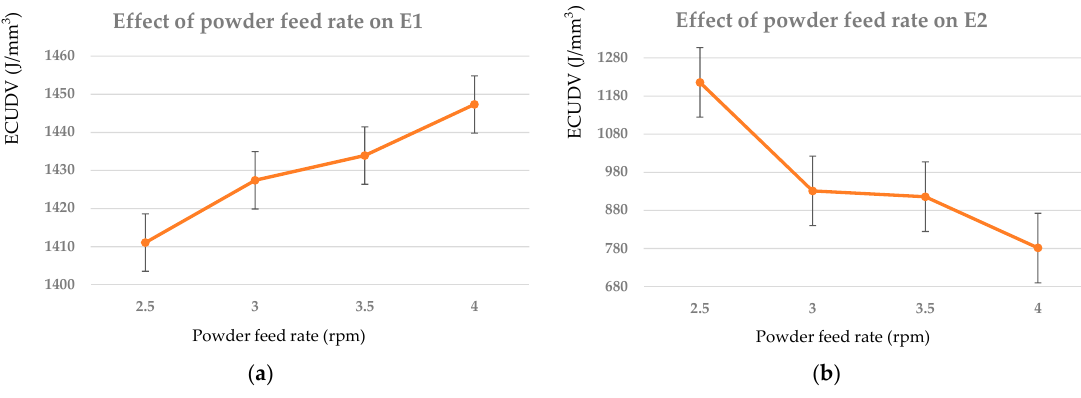
Figure 6. Effect of powder feed rate: ( a ) theoretical value and ( b ) actual value. Powder: Inconel 718.